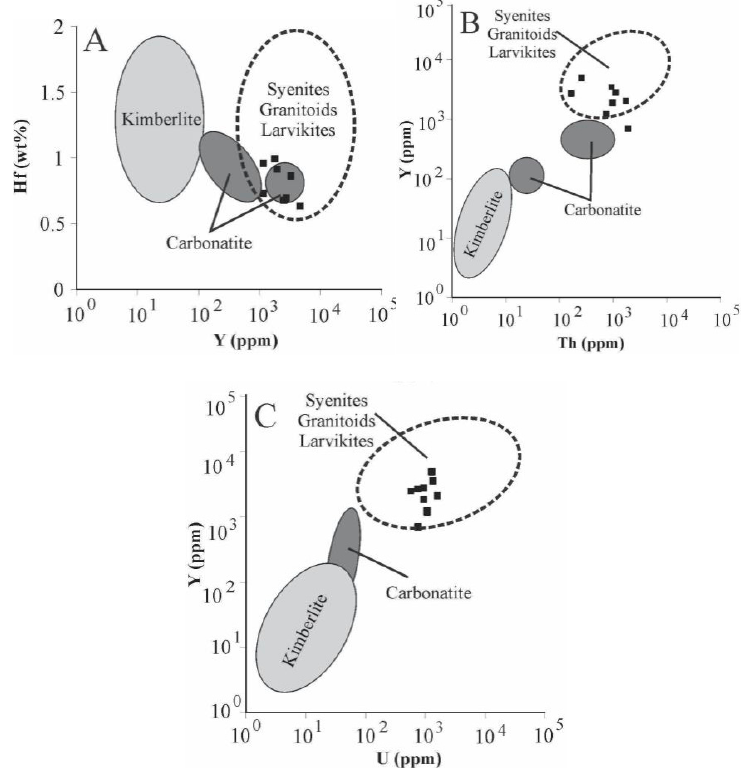
Figure 10. Trace element plots from accessory zircons found in the Cedrolina chromitite. Different source rock fields adapted from [19]. ( A ) Hf vs. Y; ( B ) Y vs. Th; ( C ) Y vs.